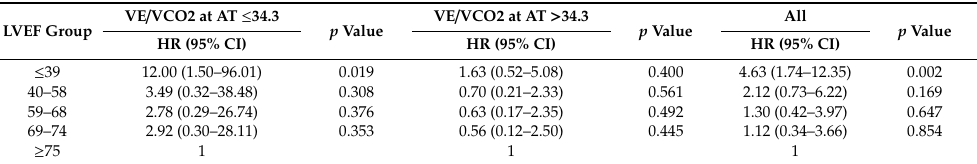
Figure 3. The relationship between LVEF and CV outcomes in patients with ventilatory inefficiency (VE/VCO2 at AT >34.3) and in patients without ventilatory inefficiency (VE/VCO2 at AT ≤ 34.3). The lower LVEF subgroup (LVEF ≤ 39%) was associated with a significantly increased risk of CV mortality or HF hospitalization relative to the LVEF ≥ 75% subgroup among patients without ventilatory inefficiency ( p = 0.019). There was no prognostic predictability relative to low EF (LVEF ≤ 39%) among patients with ventilatory inefficiency ( p = 0.400). LVEF: left ventricular ejection fraction, CV: cardiovascular, VE/VCO2 at AT: ventilatory equivalent for carbon dioxide at anaerobic threshold, HF: heart failure. Table 4. Adjust hazard ratio associated with LVEF for major cardiovascular events by baseline LVEF category relative to LVEF ≥ 75.